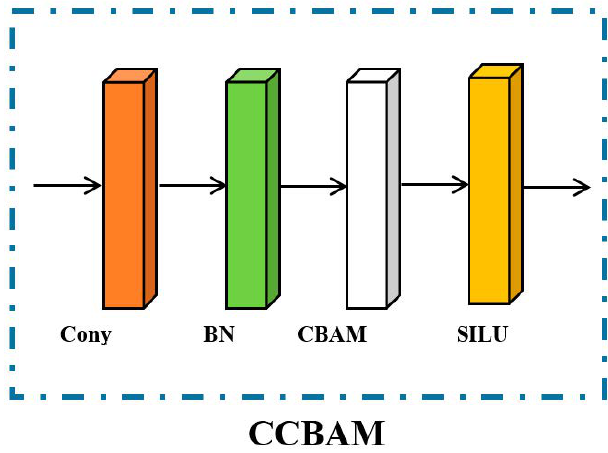
Figure 5. The architecture of the CCBAM.